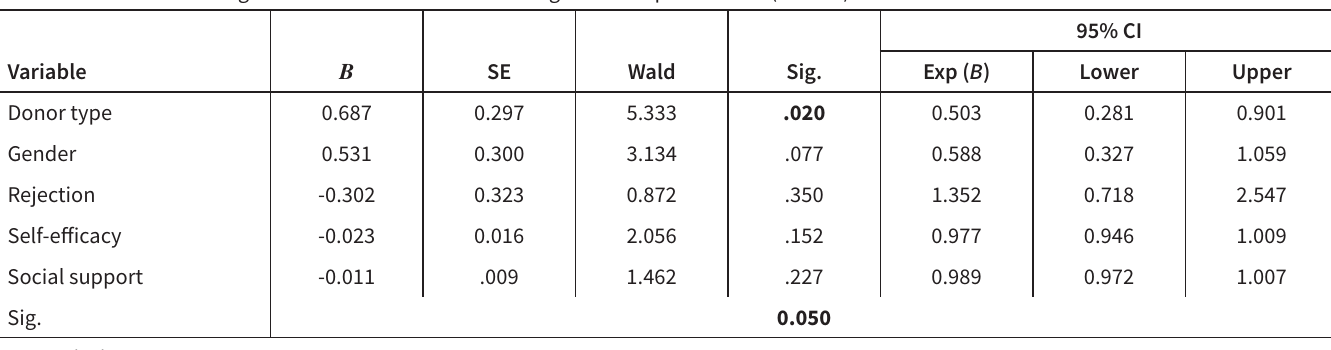
Table 3. Factors Affecting Medication Adherence According to Self-Reported Data (n = 208)